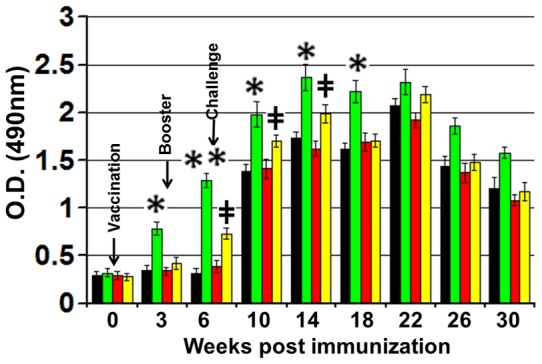
IFN-γ response.PBMCs isolated from animals bled at various time points were stimulated with Ag-mix (15 μg/ml) or PPDj (10 µg/ml) in 200ul RPMI for 72 hrs at 37C in a humidified atmosphere supplemented with 5% CO2. IFN-γ levels in the tissue culture supernatant were determined with a BOVIGAM kit following the manufacturer's protocol. Results are expressed as OD values and error bars indicate 1 standard deviation from the mean. (PBS Vs 316F *indicates p<0.05 ** indicates p<0.01, PBS Vs Sal-Ag ‡ indicates p<0.05 ‡‡ indicates p<0.01).